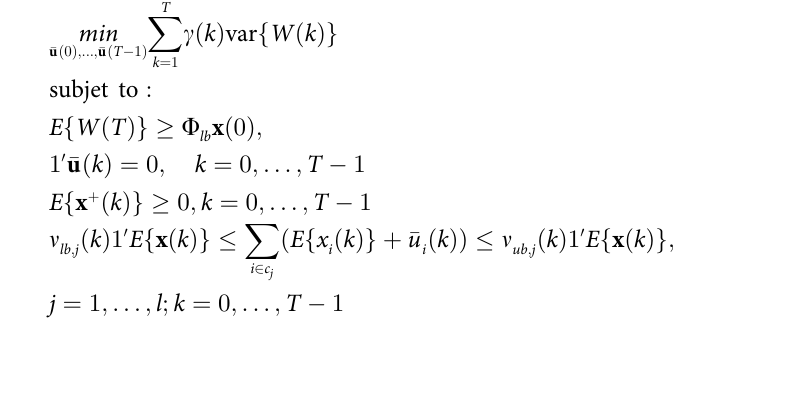
Table 1. Assets considered to this study.